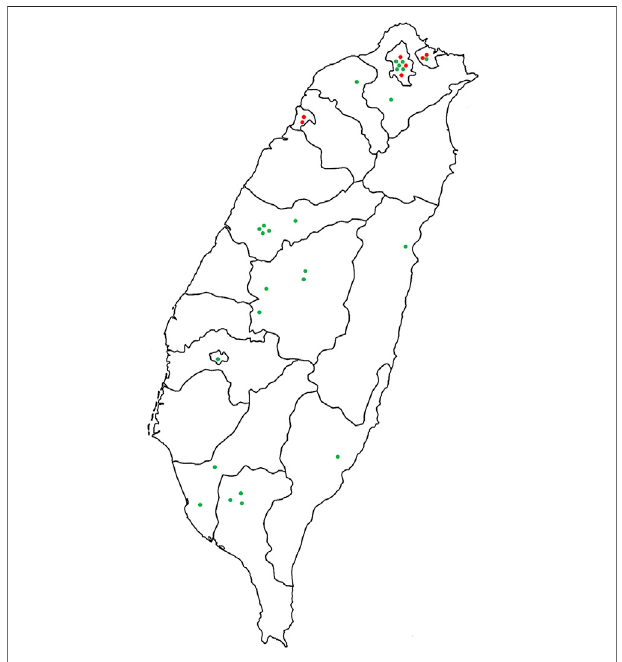
FIGURE 1 | Geographical distribution of 32 stores with available bitter tea formulations. Red dots indicate that the store provided bitter tea formulation but did not receive interviews (seven stores), and green dots indicate that the store provided complete bitter tea formulation and accepted interviews (25